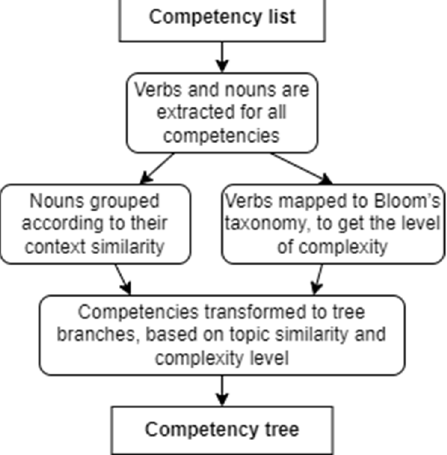
Figure 1. Abstract model of competency list transformation to competency tree.